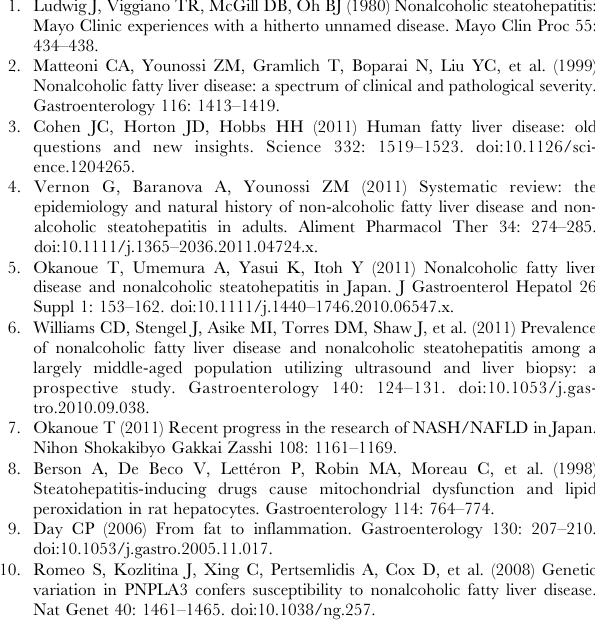
Figure S1 QQ plot of the GWA study comparing distribution of the observed and expected p -values. Upper box is expressed in antilog scale and the lower box is expressed in –log 10 scale. The X- and Y-axis correspond to expected and observed p -values. Blue and red dots denote before and after correction by genomic control method ( l = 1.04), respectively. Table S1 List of the SNPs showing p , 1.0 6 10 2 5 in the GWA study. Reference (A1) and non-reference (A2) alleles refer to NCBI Reference Sequence Build 36.3 with the effective allele marked by an asterisk. Genotyping results are shown by genotype count of A1A1/A1A2/A2A2 with allele frequency of A2 in parenthesis. { P -values are calculated by exact trend test with odds ratios (OR) calculated for A2 with 95% confidence interval (CI).